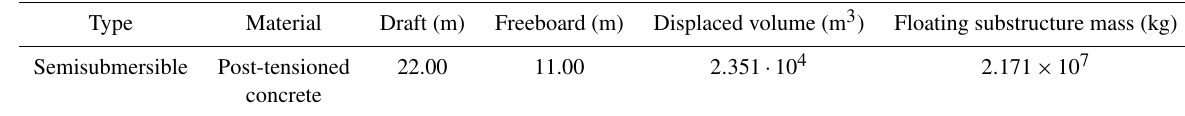
Table 2. Main properties of the OO-Star Semi floating substructure.